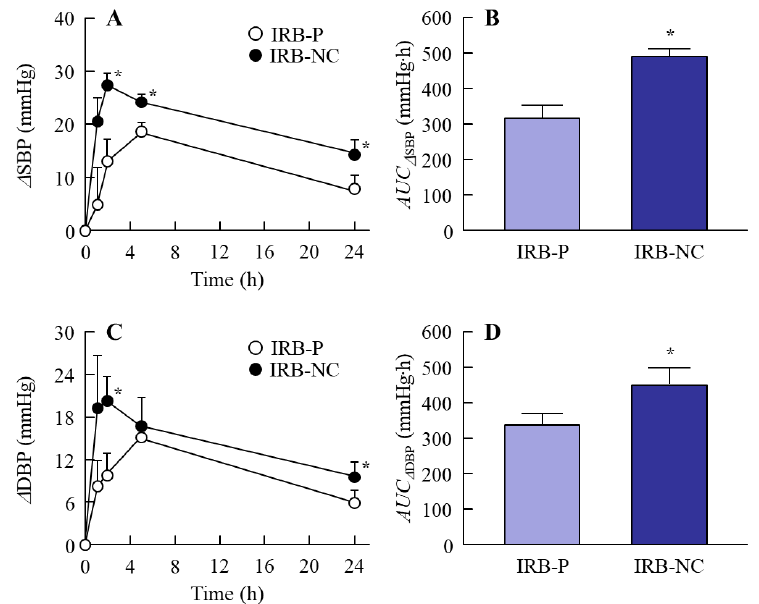
Figure 6. Changes in BP in the rats orally administered the IRB-NC suspensions. ( A , B ) ΔSBP profile ( A ) and AUC ΔSBP ( B ) in the rats orally administered the IRB-P and IRB-NC suspensions. ( C , D ) ΔDBP profile ( C ) and AUC ΔDBP ( D ) in the rats orally administered the IRB-P and IRB-NC suspensions. IRB- P, IRB-P-suspension-administered SHR-SP rats. IRB-NC, IRB-NC-suspension-administered SHR-SP rats. n = 7. * p < 0.05 vs. IRB-P for each category. The BP-reducing effect of the IRB-NC suspensions was significantly higher than that of the IRB-P suspensions.